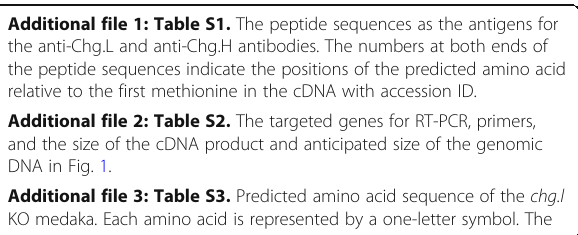
Additional file 3: Table S3. Predicted amino acid sequence of the chg.l KO medaka. Each amino acid is represented by a one-letter symbol.